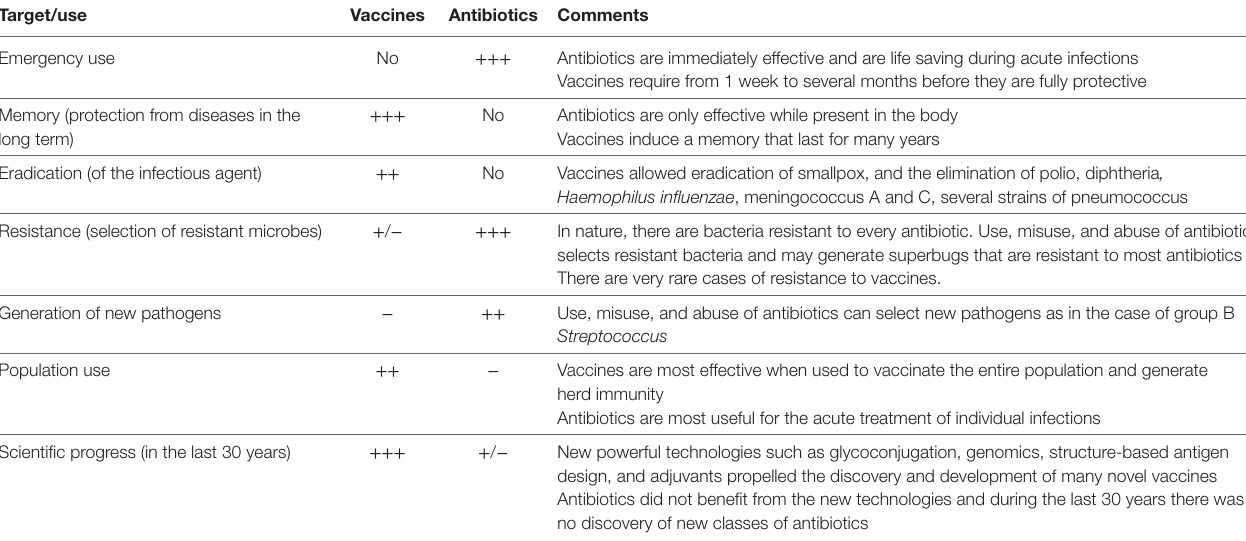
TABLe 1 | Comparison of the characteristics of vaccines and antibiotics in their capacity to fight